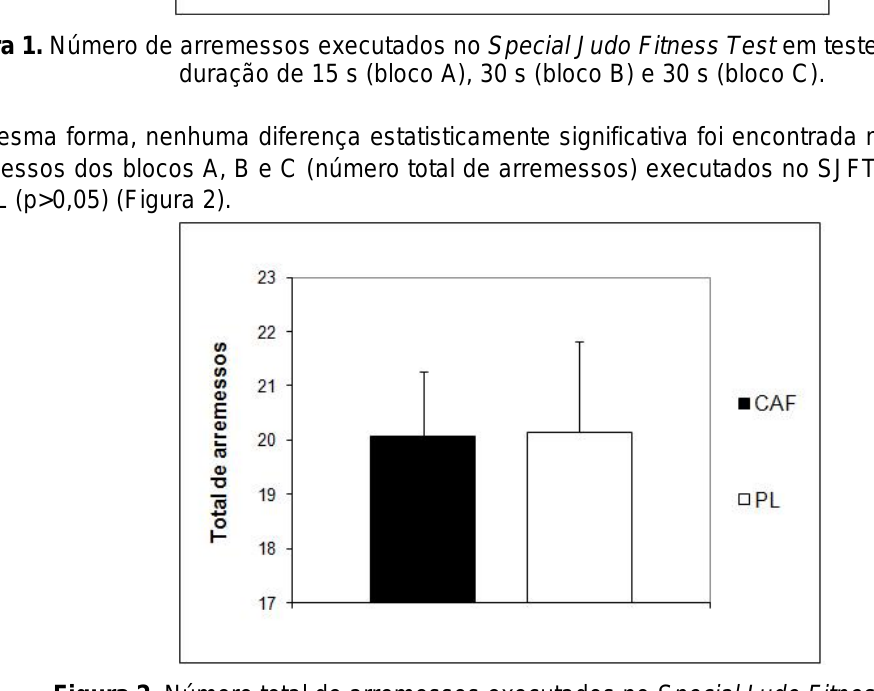
Na figura 3 são apresentados valores referentes à resposta da FC imediatamente